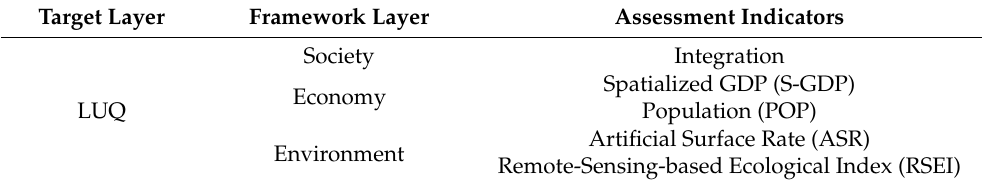
Table 1. LUQ Assessment framework and indicators.